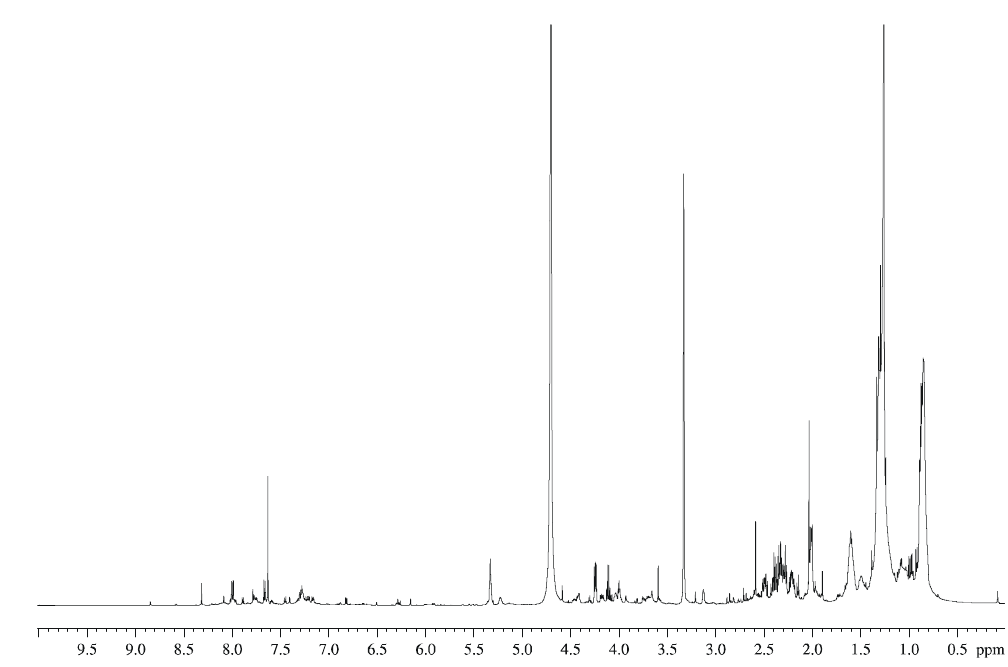
Figure 9. 1 H NMR spectrum of organic extract from SN_TAE2020 in CDCl 3 /CD 3 OD 1:1. The spectrum was recorded at 298K, at 600 MHz.